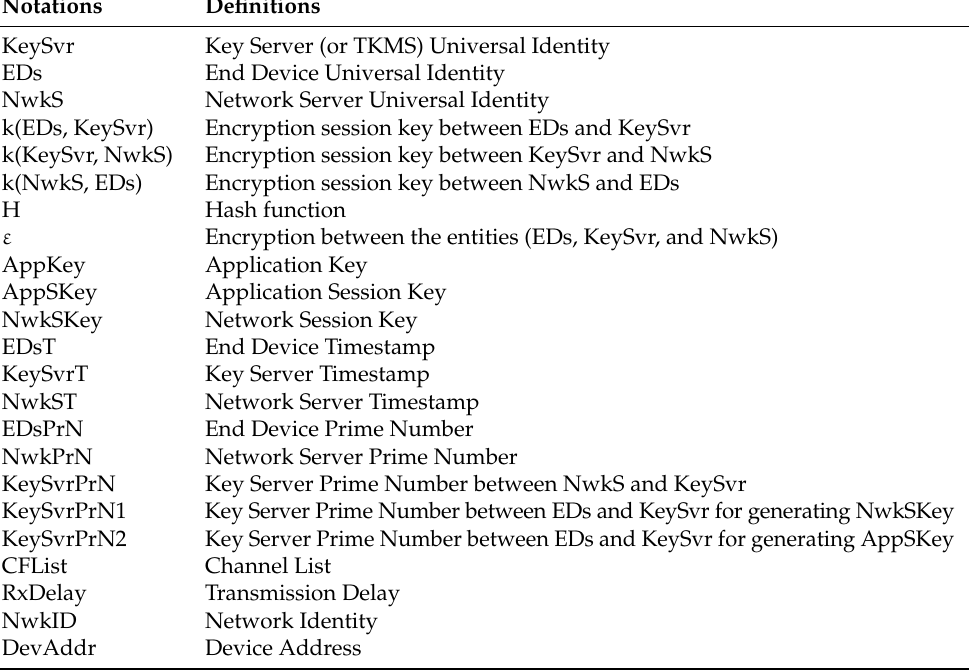
Table 1. Notation and